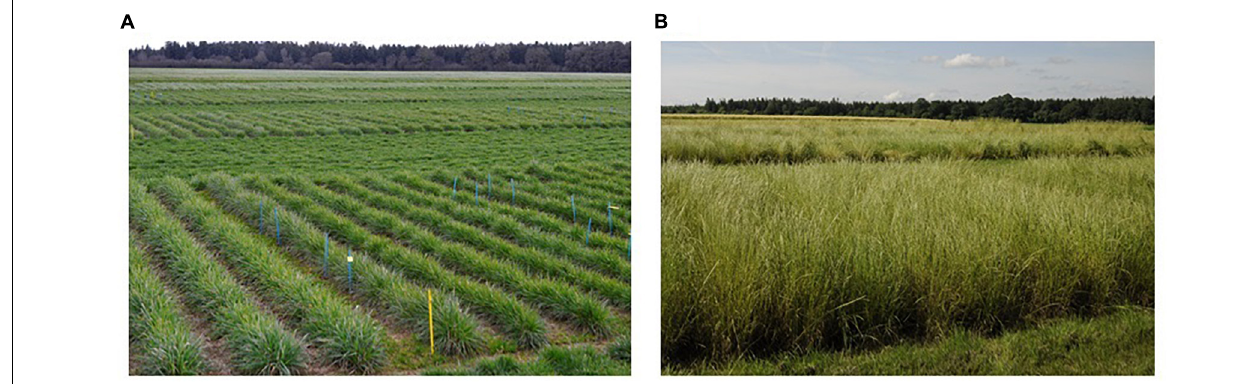
FIGURE 1 | Effect of the reproductive development on the above-ground morphology in Lolium perenne . (A) Cultivars of Lolium perenne at vegetative state on March 20th 2018. (B) Same plants at reproductive state on June 8th 2018. The experiment is conducted by GEVES in Lusignan (France).